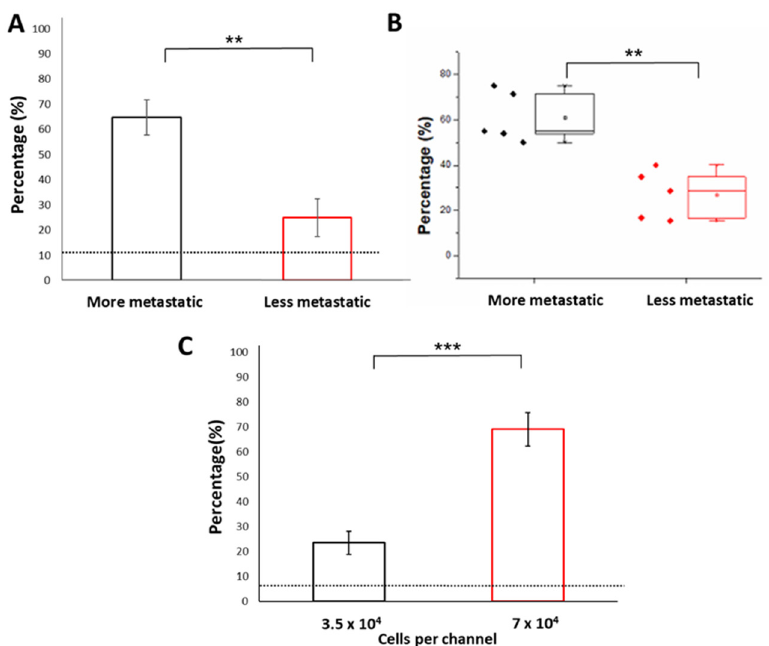
Figure 3. Detection of metastatic phenotypes with the WB biosensor. ( A ) Bar chart reflecting the chemotactic preference of worms to samples from more metastatic cancer cells (MDA-MB-231) compared to samples from less metastatic cancer cells (MCF-7). The dotted line corresponded to the proportion of C. elegans with samples from healthy controls (fibroblast). ( B ) The proportion of C. elegans when exposed to samples denatured by heat treatment. ( C ) The proportion of C. elegans when exposed to samples obtained from larger clusters of higher metastatic potential. The dotted line corresponded to the proportion of C. elegans with samples from PBS buffer standards. *** states for p < 0.0001, ** states for p < 0.005.